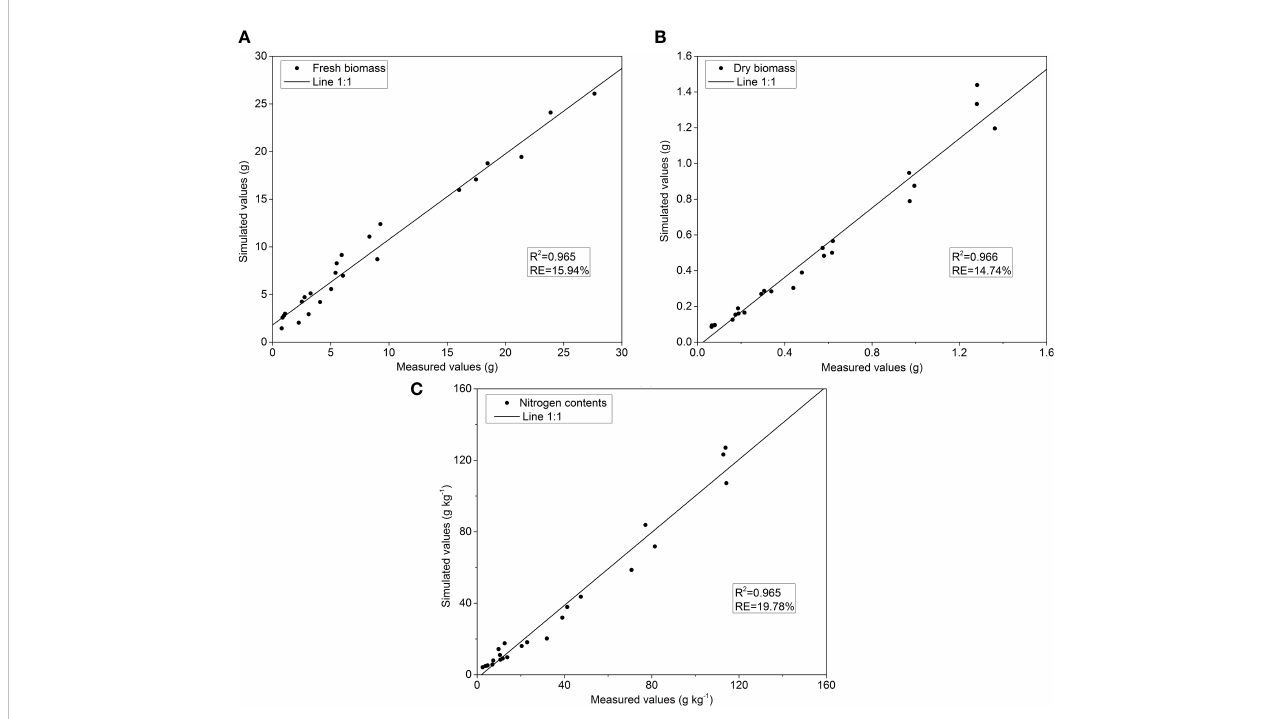
FIGURE 6 The relationship between measured values (x-axis) and simulated values (y-axis) for (A) FW (B) DW and (C) N contents under different N application rates in pakchoi. R 2 = the correlation coef fi cient of simulated and measured values and RE = relative standard error for simulated and measured values (Equation